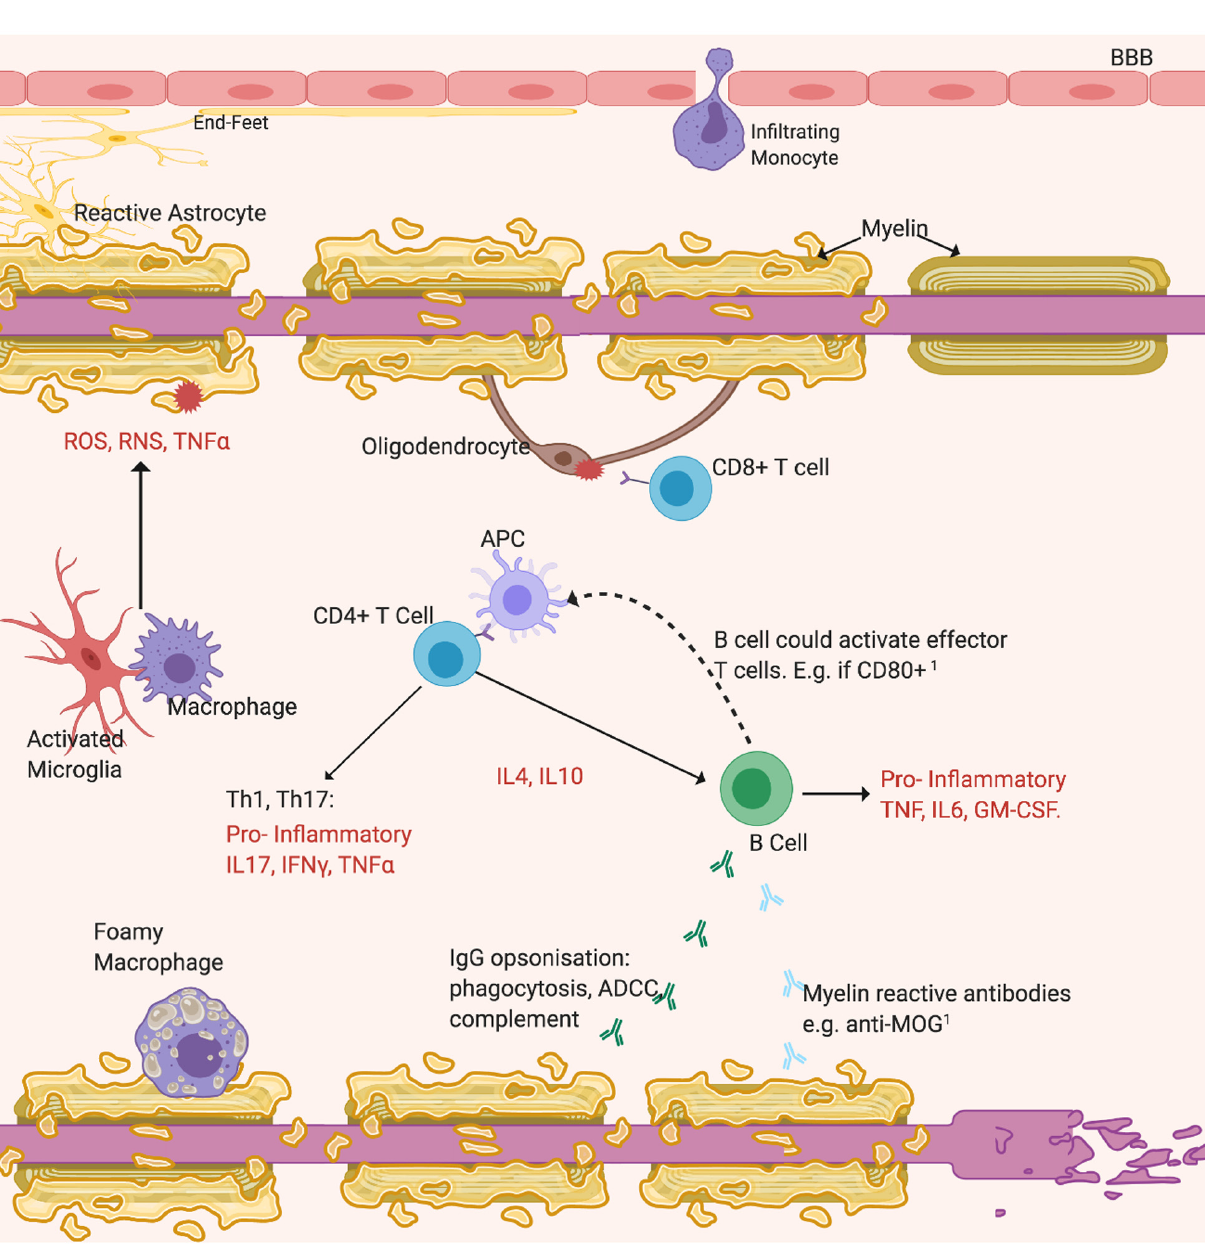
Figure 2. Demyelination may derive from antibody attack. Opsonisation by non-specific IgG activates the cytotoxic complement system and ADCC. The emerging importance of B cells is highlighted by recent findings 44 . Additional roles include possibly secreting anti- myelin antibodies and acting as APCs to increase T cell activation 45 , labelled 1 . Cytotoxic CD8 + T cells react against self-antigens expressed by oligodendrocytes. Resident microglia or peripheral macrophages phagocytose myelin residues and debris. Reactive astrocytes, activated microglia and Th cells activated by APCs drive inflammation by secreting pro-inflammatory cytokines (TNFα, IFNγ, interleukins) and neurotoxicity by releasing free radicals (ROS, RNS) 43 . Subsequently to myelin loss, axons degenerate. Figure created with BioRender